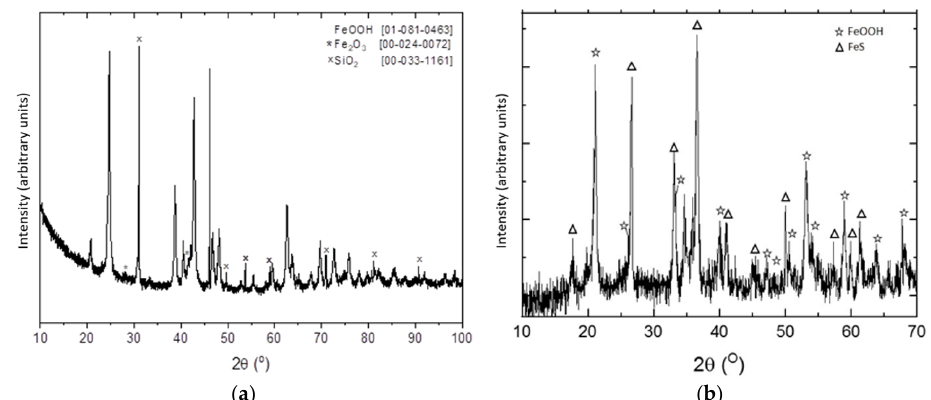
Figure 4. XDR diagrams of the pristine ( a ) and after H 2 S uptake ( b ) adsorbent.